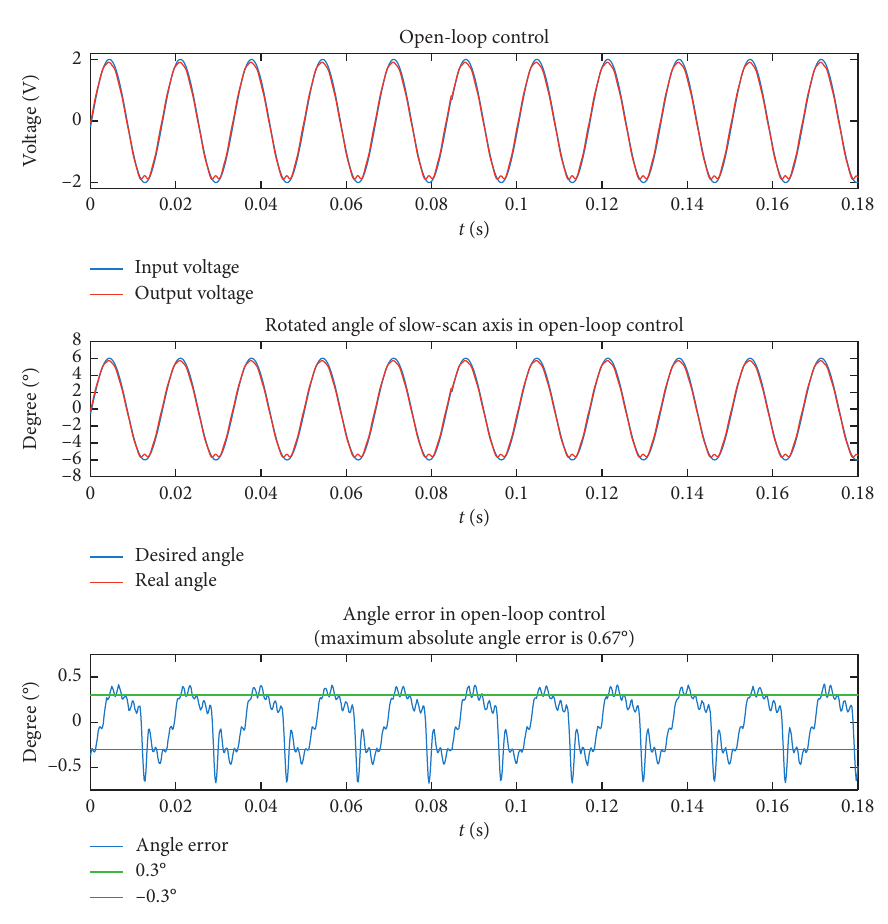
Figure 6: Slow-scan axis control of electromagnetic micromirror in open-loop